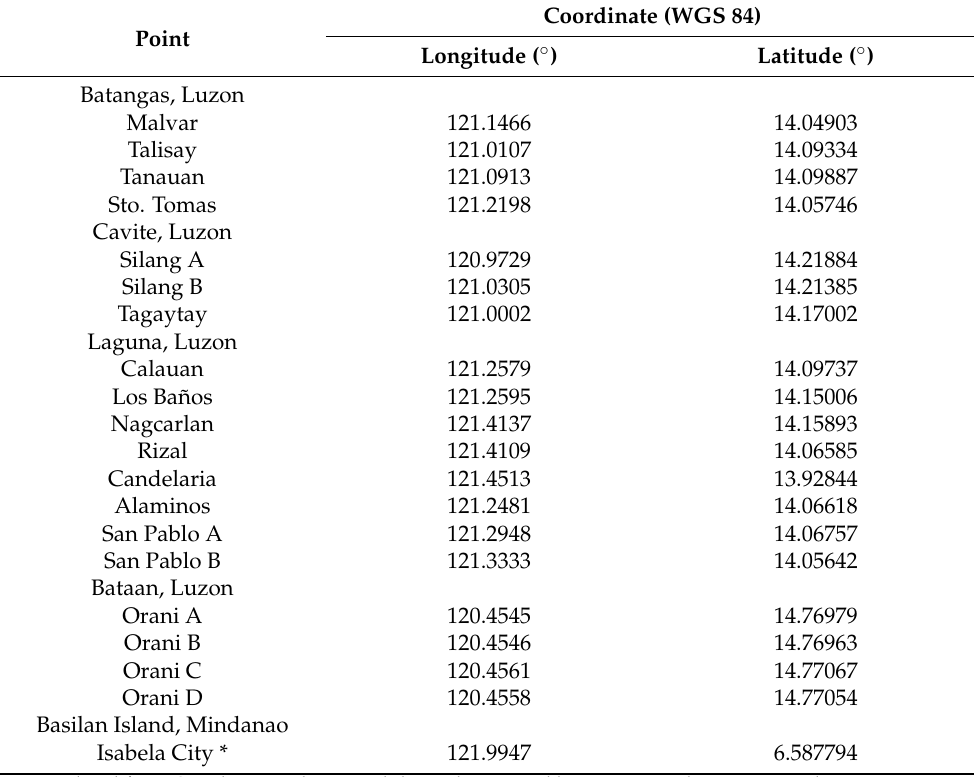
Table 1. Occurrence points of Comperiella calauanica recorded from April 2014 to January 2016.